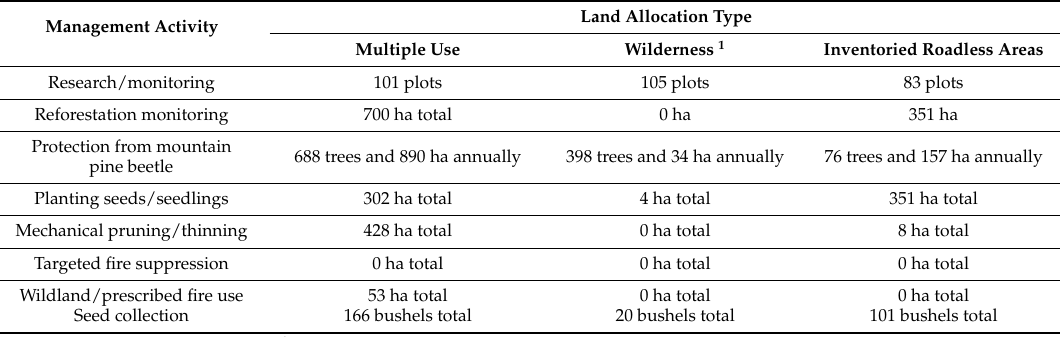
Table 2. Estimated minimal extent of monitoring and management treatments for WBP for federal lands in the GYE by land allocation type as coordinated by the GYCC WBP Subcommittee. Data are estimates provided by the GYCC WBP Subcommittee with most of the U.S. Forest Service data compiled from the Forest Service Activity Tracking System (FACTS) in September 2015. Research/monitoring plots are described in [67].